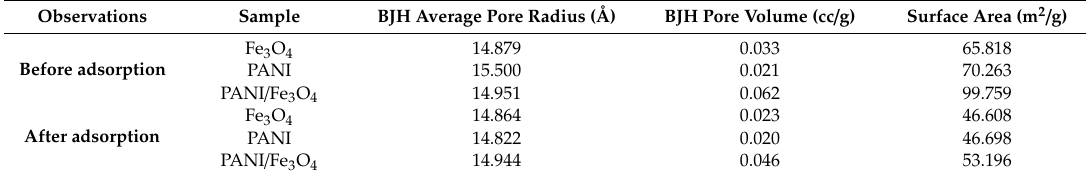
Table 1. Surface area and Barrett, Joyner, and Halenda (BJH) para meters of Fe 3 O 4 , PANI, and PANI/Fe 3 O 4 composites before and after adsorption of BB3 dye.